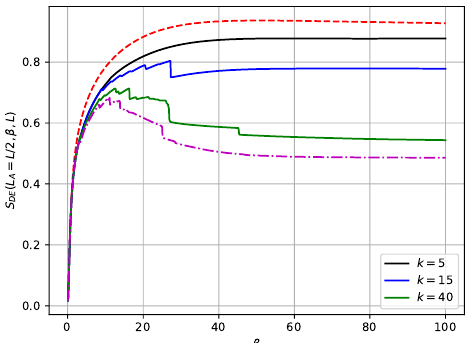
Figure 20. The disentangled entropy S DE at the middle cut for di(cid:11)erent choices of two-site disentangler given by (C.2), for a system size L = 30. The dashed line shows the entropy of the TFD state without disentangling, while the dash-dotted line is the disentangled entropy using the prescription